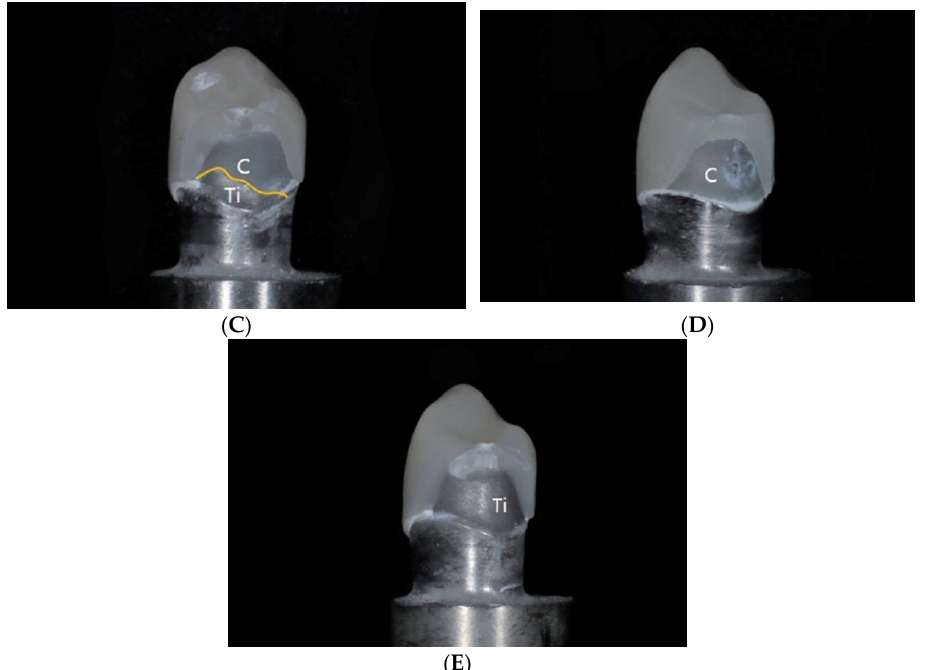
Figure 5. Fracture failure patterns in tooth and titanium abutments ( A ): PICN_TO specimen showing mixed failure pattern. ( B ): LS_TO specimen showing adhesive failure pattern. ( C ): LS_TI specimen showing mixed failure pattern. ( D ): RNC_TI specimen showing an adhesive failure pattern; the cement was attached to the abutment. ( E ): ZLS_TI specimen showing an adhesive failure pattern; the cement was attached to the crown fragment. PICN, polymer-infiltrated-ceramic-network; TO, tooth abutment; LS, lithium disilicate; TI, titanium abutment; RNC, resin nano ceramic; ZLS, zirconia-reinforced lithium silicate; C, cement; To, tooth; Ti, titanium.